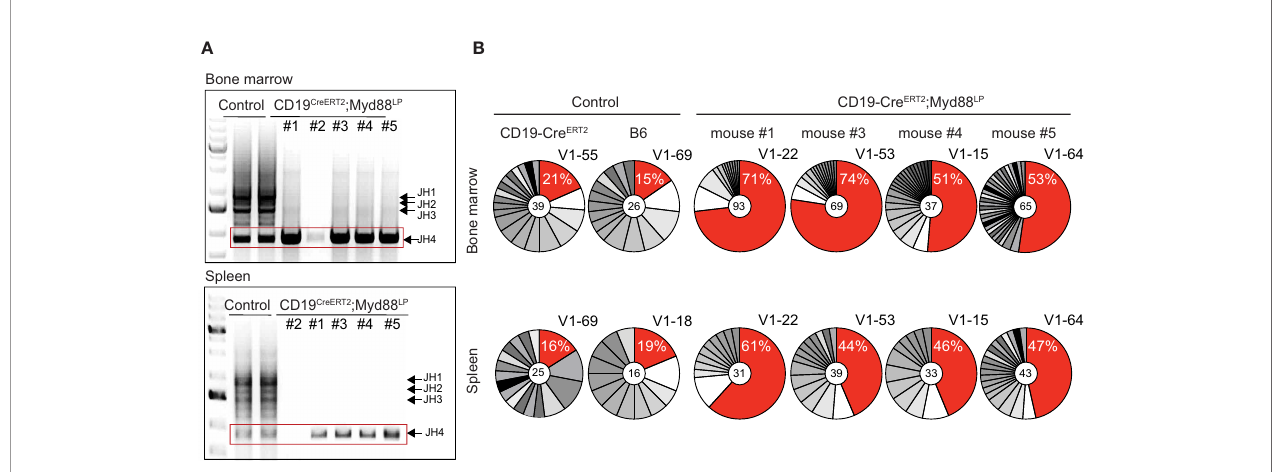
FIGURE 5 | CDR3 analysis of rearranged VDJ genes shows expansion of clonally related plasma cells in aged Cre ERT2 ;Myd88 L252P mice. Genomic DNA was puri fi ed from GFP-reporter-positive TACI + CD138 + plasma cells isolated from bone marrow and spleen of CD19-Cre ERT2 ;Myd88 L252P mice 70 weeks after tamoxifen induction. (A) PCR ampli fi cation of rearranged J558 family V genes from bone marrow (upper panel) and spleen (lower panel). Bands corresponding to all four JH segments appeared in the controls, while in Cre ERT2 ;Myd88 L252P mice only J H 4 rearrangements could be detected. (No rearrangements were detected in mouse #2). (B) J H 4 bands (red rectangle shown in A ) were cloned and sequenced. Clonal analysis based on CDR3 sequence revealed that in each mouse the same clones were most frequently detected in the bone marrow (upper panel) and spleen (lower panel). For the most frequently detected clonotype (red sector in pie chart), the % of sequences detected and the V H J558 family member is given. V H genes and VDJ rearrangements of the most frequent clonotypes were shared in bone marrow and spleen of each CD19 ‑ Cre ERT2 ;Myd88 L252P mouse, while they differed in bone marrow and spleen of controls and between the controls. Each pie chart represents one mouse. (See also Supplementary Figures 9 and 10